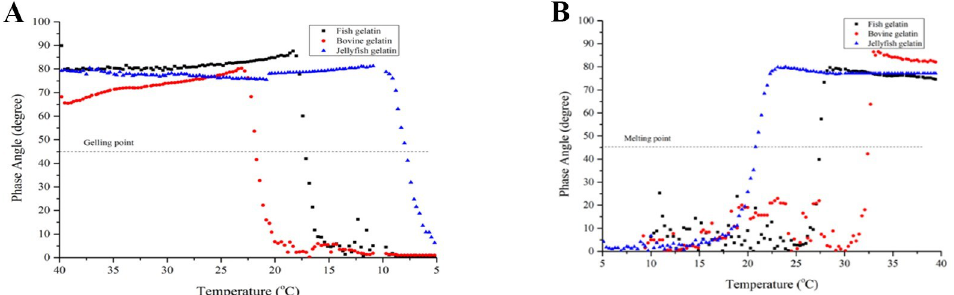
Fig 1. Dynamic viscoelastic profile changes in three gelatins during gelling and melting; (A) during gelling; (B) during